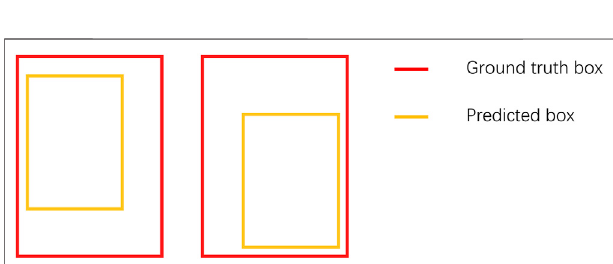
FIGURE 5 | Example of the disadvantage of GIoU, in which the two predicted boxes have different locations but the same size, making the same